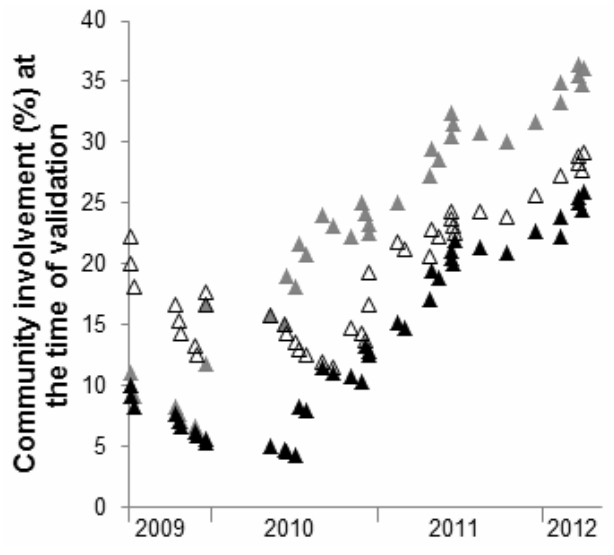
Fig. 5 . The trend over time in the involvement of local stakeholders in monitoring forest biomass (black triangle), biodiversity (shaded triangle), and livelihoods (white triangle) in forest carbon projects validated by the Climate, Community and Biodiversity Alliance from July 2009 to April 13, 2012 ( n = 50 forest carbon schemes). The monitoring schemes with local stakeholder involvement belong to categories 2 to 5 in Fig.